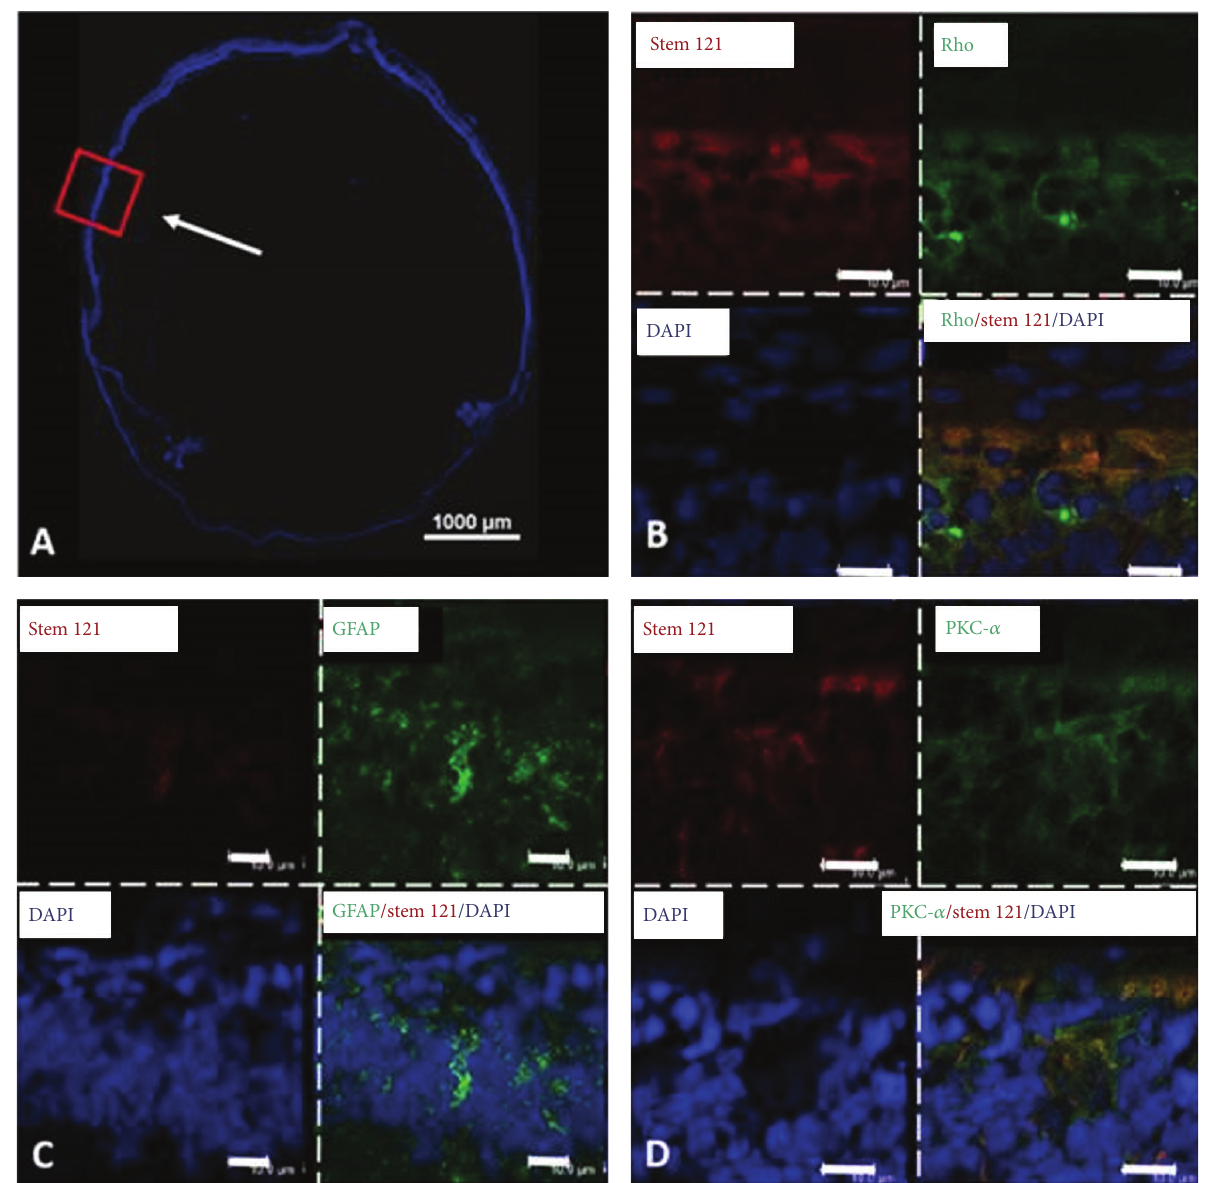
Figure 5: Observation of differentiation of human Wharton’s jelly-derived MSCs into retinal cell phenotypes in RCS rats by confocal microscopy. Confocal microscopy picture of the whole eye (A) and magnified pictures of the transplanted region (B–D). The red box indicates the magnified region, and the white arrow demonstrates the transplanted region. The antibodies used were anti-PKC- 𝛼 (bipolar cell), anti- human/rat rhodopsin (rod photoreceptor), anti-human stem 121 (MSC), and anti-GFAP (M¨uller glial cells). DAPI was used to stain the nucleus in the retinal layer. Colocalization of DAPI (blue) and stem 121 (red) with PKC- 𝛼 (green), GFAP (green), and rhodopsin (green) was found at day seventy after transplantation, suggesting that human Wharton’s jelly-derived MSCs have the ability to differentiate into retinal neurons or to fuse with the degenerating neurons. Scale bar indicates 10 𝜇 m. Modified with permission from Creative Commons Attribution License